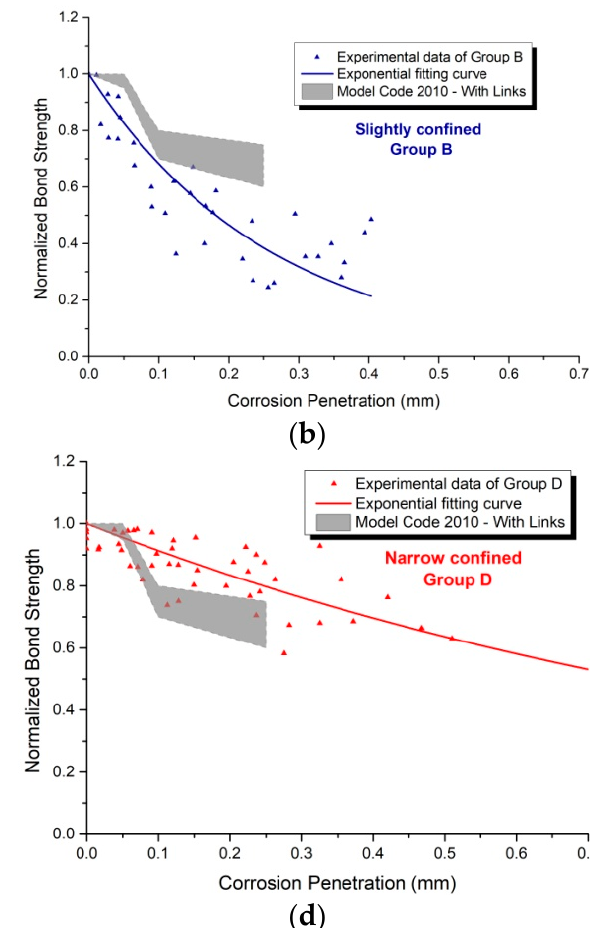
11 of 21 Table 4. Parameters by regression analysis for the exponential predictive model.